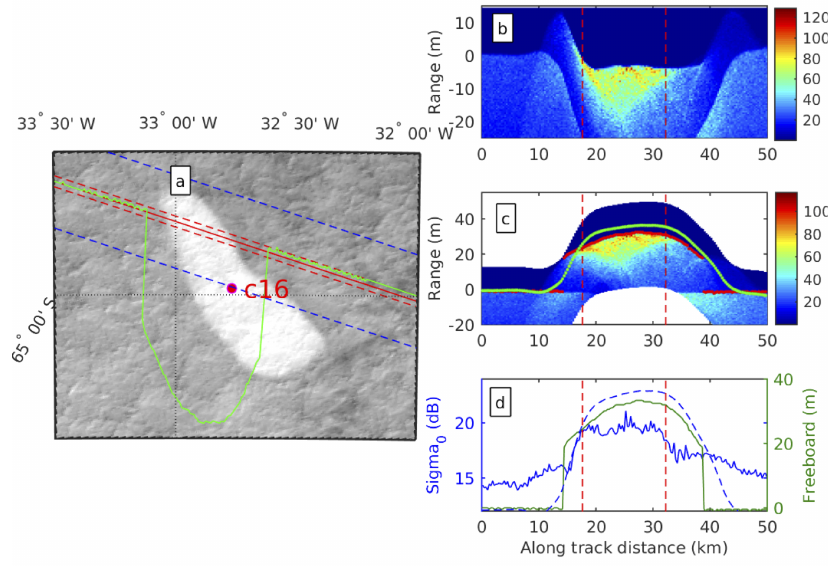
Figure 24. ( a ) MODIS image on 20 March 2013 16:45 UT and Jason-2 descending pass 180 Cycle 173 (20 March 2013 12:48UT). The red and blue dashed lines indicate the width of the fist range and last bins, respectively, and the green line the elevation profile. ( b ) Jason-2 waveforms over C16. The dashed red lines indicate the iceberg limits from MODIS image. ( c ) Re-tracked waveforms using the tracker position, the green line represents the tracker position and the red line the elevation profile using a dedicated re-tracker. ( d ) Re-tracked elevation profile (green line), tracker position (dashed green line) and measured backscatter (blue